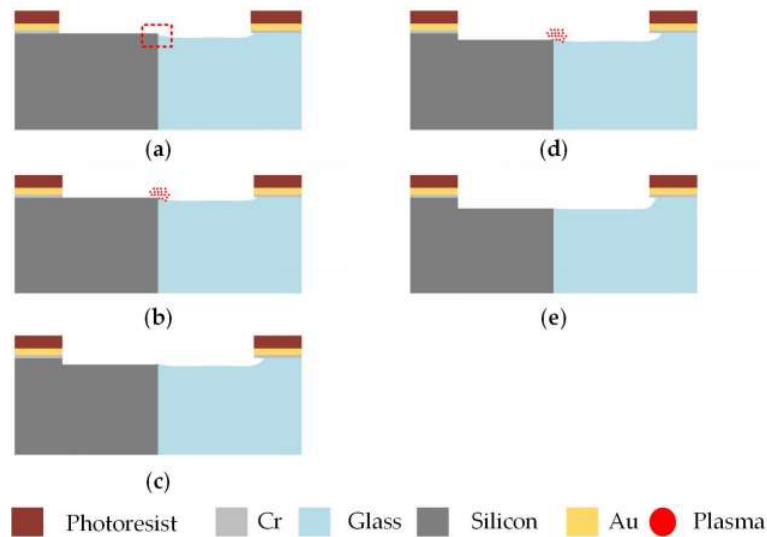
Figure 8. Optimized process flow for fabricating a 2 µ m cavity. ( a ) The glass was etched by HF-based solution with added HCl for a few seconds; ( b ) the silicon was etched to 1 µ m using ICP etching technology; ( c ) the glass was also etched to be 1 µ m; ( d ) the silicon was etched to 2 µ m, as in step ( b ); and ( e ) the glass was also etched, as in step ( c ), to the same depth to form a 2- µ m-deep cavity.